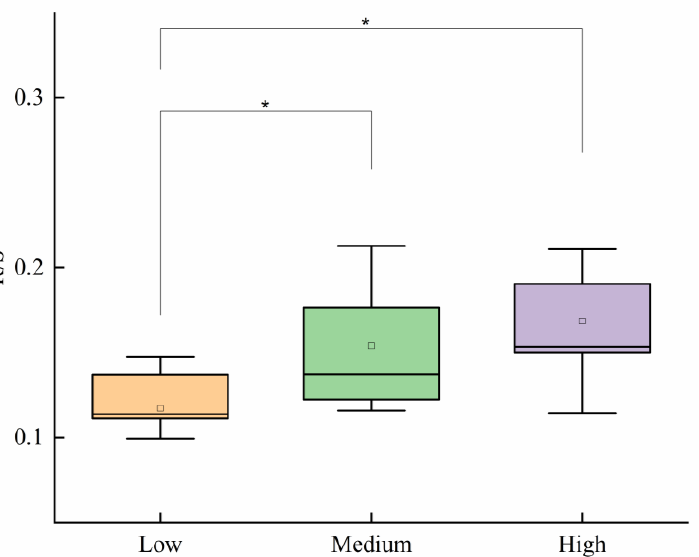
Figure 2. Differences in R/S of Pedicularis kansuensis among different invasion levels. * indicates a significant difference ( p < 0.05).